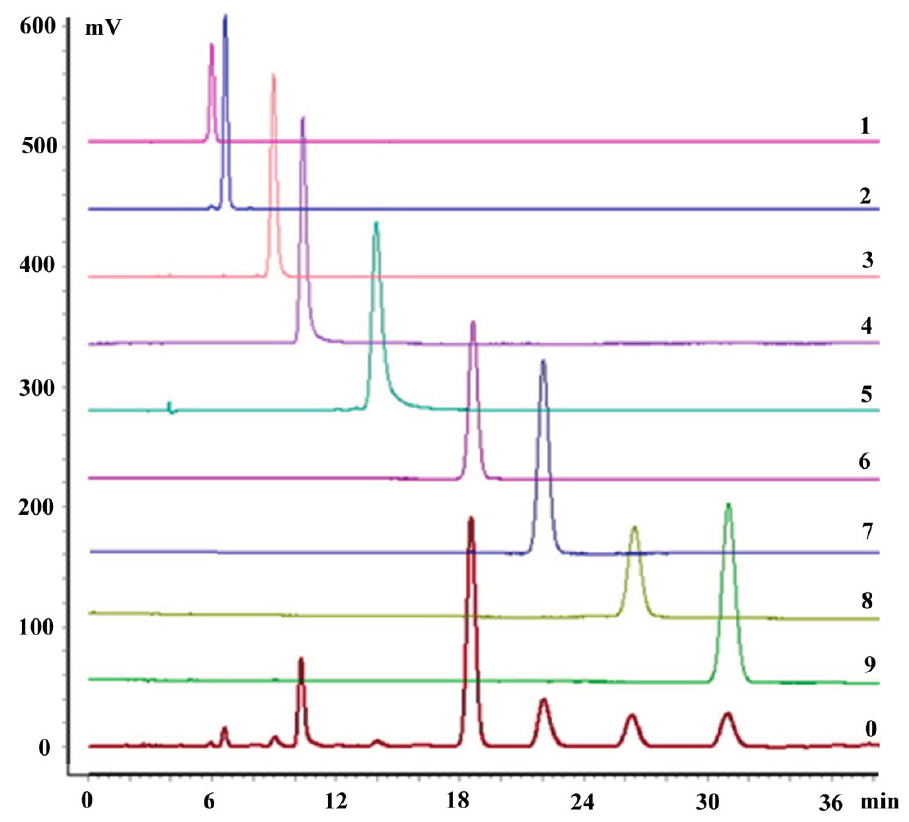
Figure 8. Typical HPLC analyses of the nine purified compounds ( 1 – 9 ) using DAD at a wavelength of 250 nm; HPLC chromatogram of the crude drugs ( 0